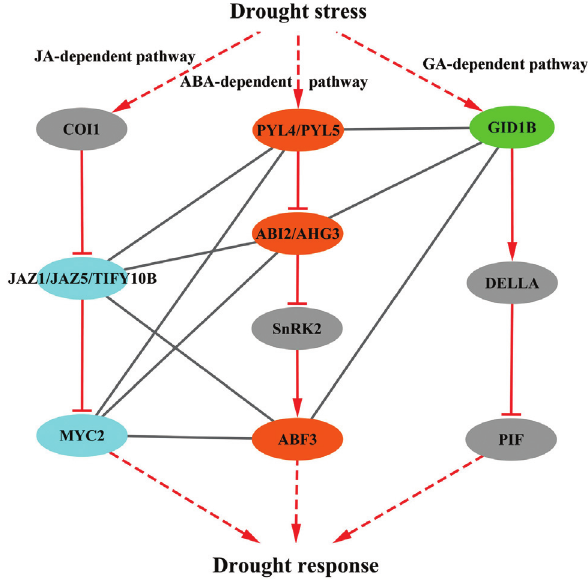
Figure 5 - A model for the interplay of ABA and the other two hormone signaling pathways in response to drought stress. The components of three different hormone pathways are represented by three different colors. ABA-dependent drought-responsive genes are depicted in orange, and ABA-independent drought-responsive genes involved in JA and GA sig- nalingaredepictedinskyblueandgreen,respectively.Interactionsamong those components are indicated by line; the gray line indicates the pre- dicted interaction, and the red line indicates that the relationship has been experimentally verified. The red dotted lines indicate multi-step